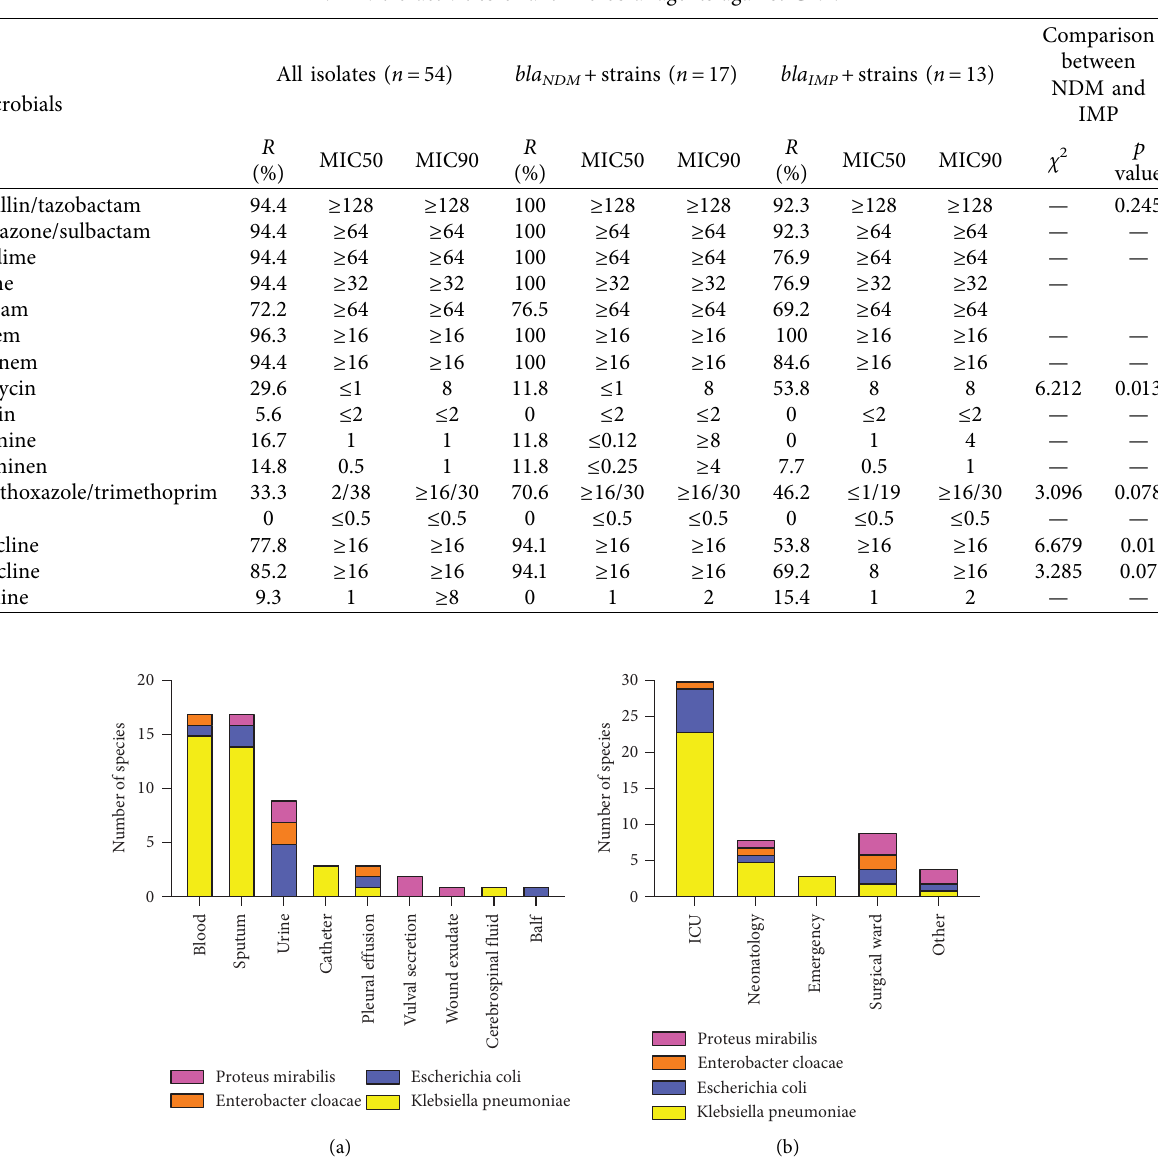
Table 1: In vitro activities of antimicrobial agents against CRE.